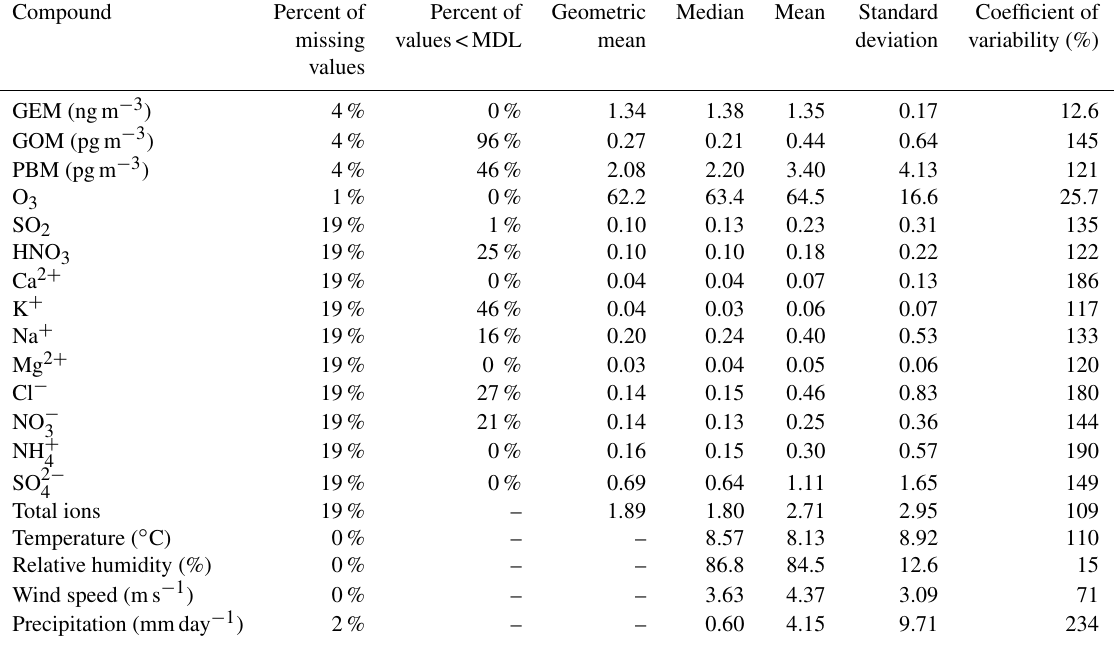
Table 2. General statistics of daily air pollutant concentrations (in µgm − 3 unless otherwise noted) and meteorological parameters in